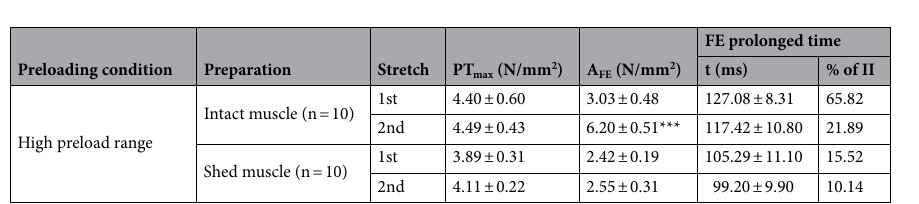
Table 2. The active stretched passive tension and relative force enhancement in excessive preload cardiac muscle fibres.